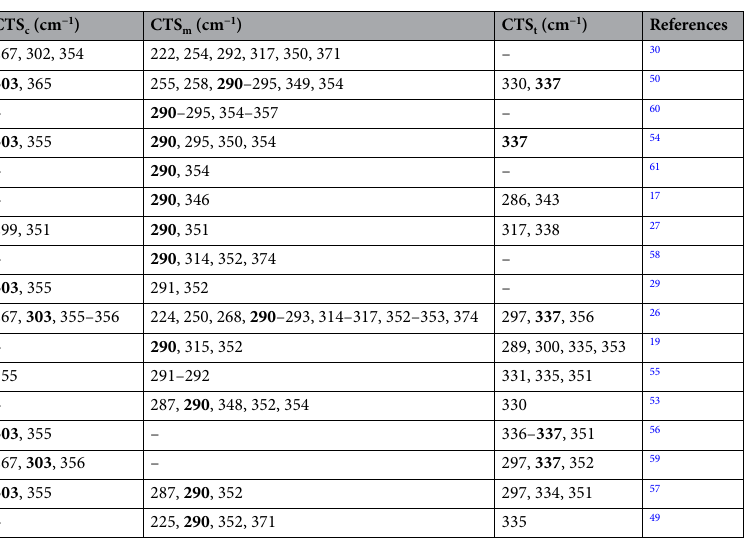
Table 1. Raman peaks of the CTS c , CTS m and CTS t structures reported in the literature with the principal peaks being